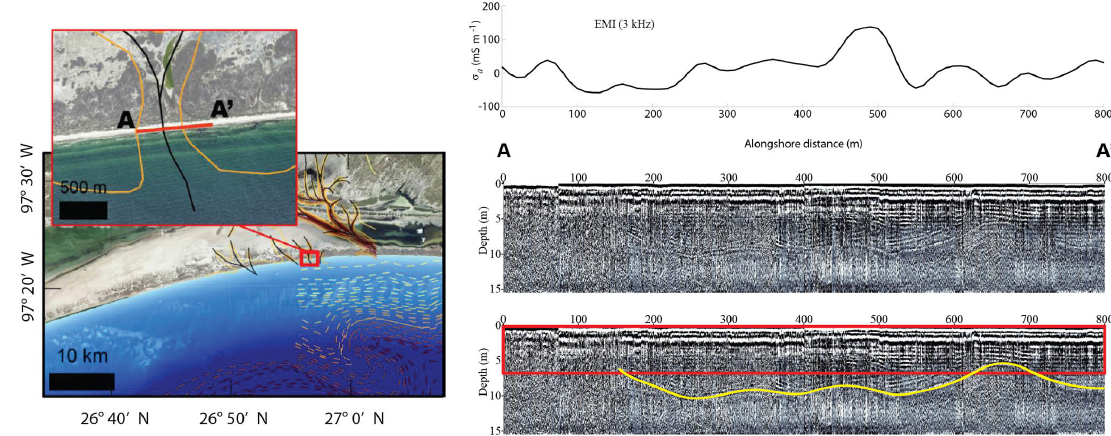
Figure 3. Comparison of EMI σ a responses from the 100km survey with 100MHz GPR data within one of the Fisk (1959) paleo-channels. The 800m segment (A–A (cid:48) ) crosses a smaller stream within the network of paleo-channels in the central zone of PAIS. The DOI of the 3kHz EMI responses is outlined by the red box on the lower GPR radargram and the interpretation of the channel base (ravinement surface) is highlighted in